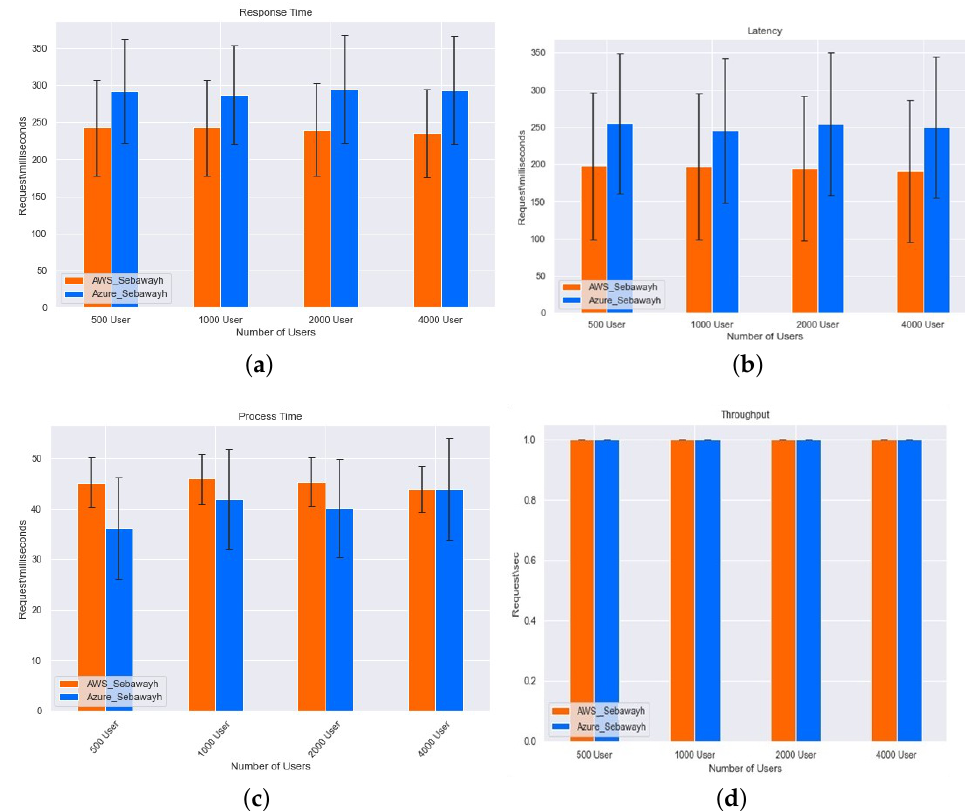
Figure 4. Comparison of the educational category API under the two platforms. ( a ) Response time of the Sebawayh application. ( b ) Latency of the Sebawayh application. ( c ) Processing time of the Sebawayh application. ( d ) Throughput of the Sebawayh